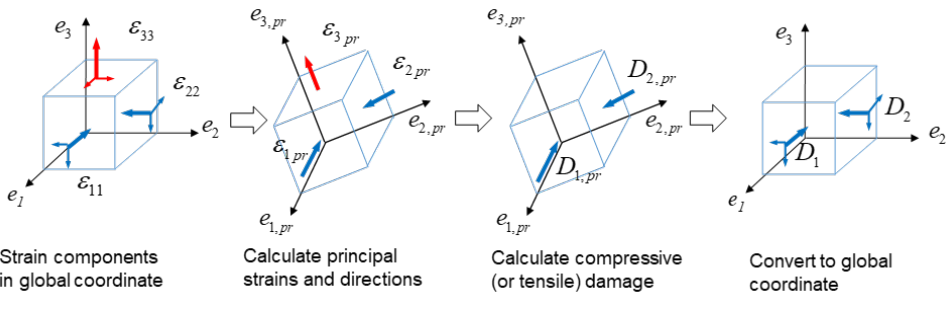
Figure 7. Damage index calculation process.